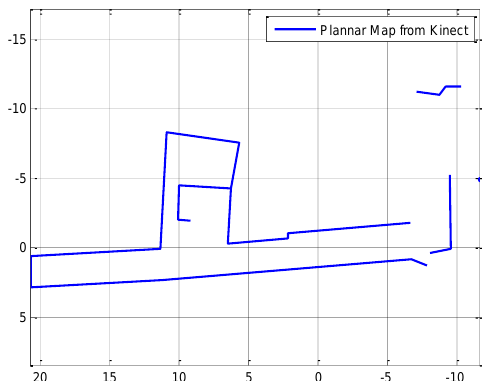
Figure 11. The floor plan result from laser scanner shown in